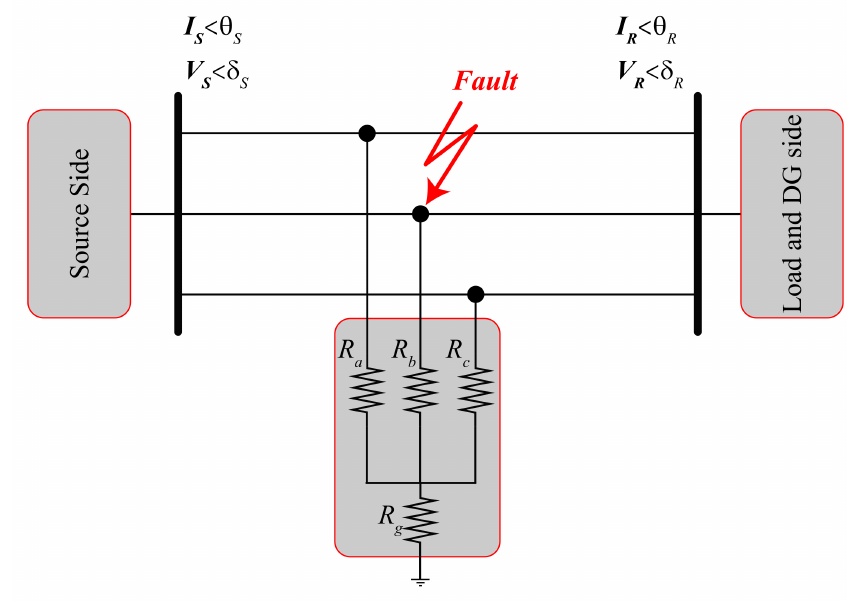
Figure 1. A three-phase-to-ground fault in a section of a distribution